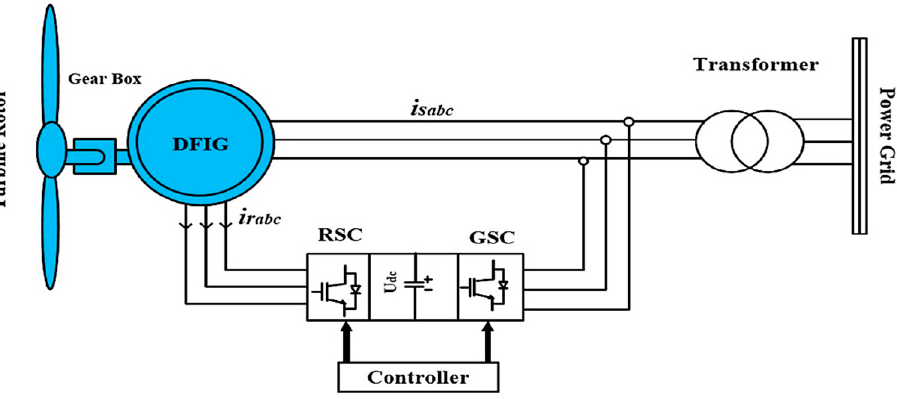
Figure 4 . DFIGs-based wind